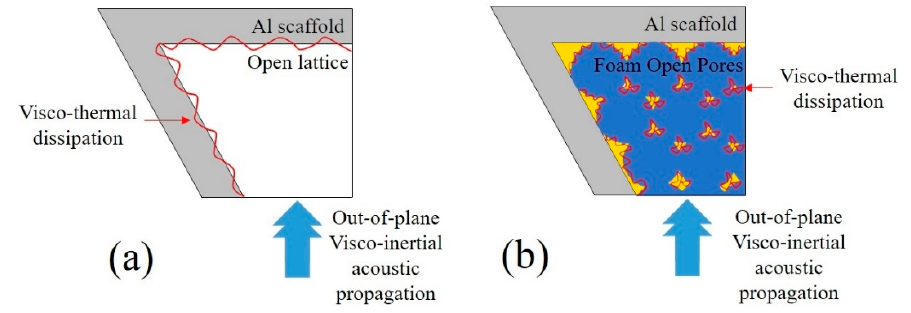
Figure 12. JCAL model in ( a ) unfilled and ( b ) foam-filled samples.